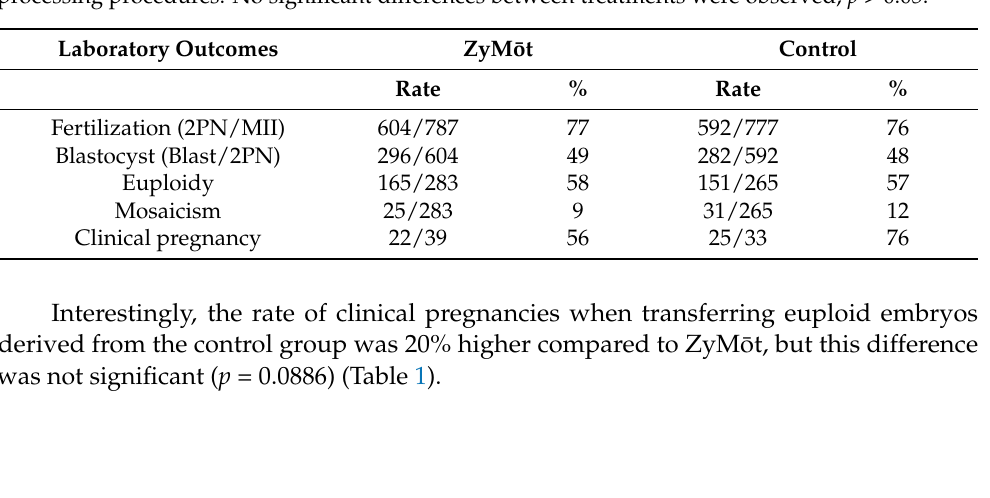
Table 1. Comparison of embryo development outcomes in sibling oocytes subjected to ICSI using ejaculates split processed with ZyM¯ot microfluidic sperm separation treatment or control sperm processing procedures. No significant differences between treatments were observed, p >